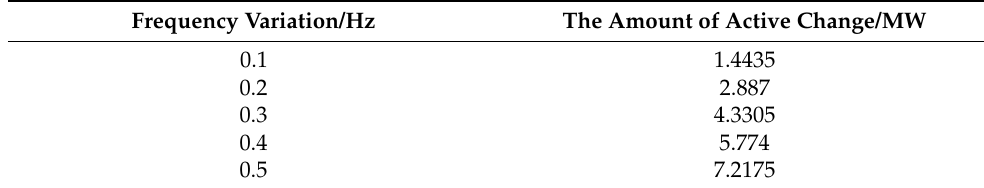
Table 3. Correspondence between allowable frequency variation and new energy access.